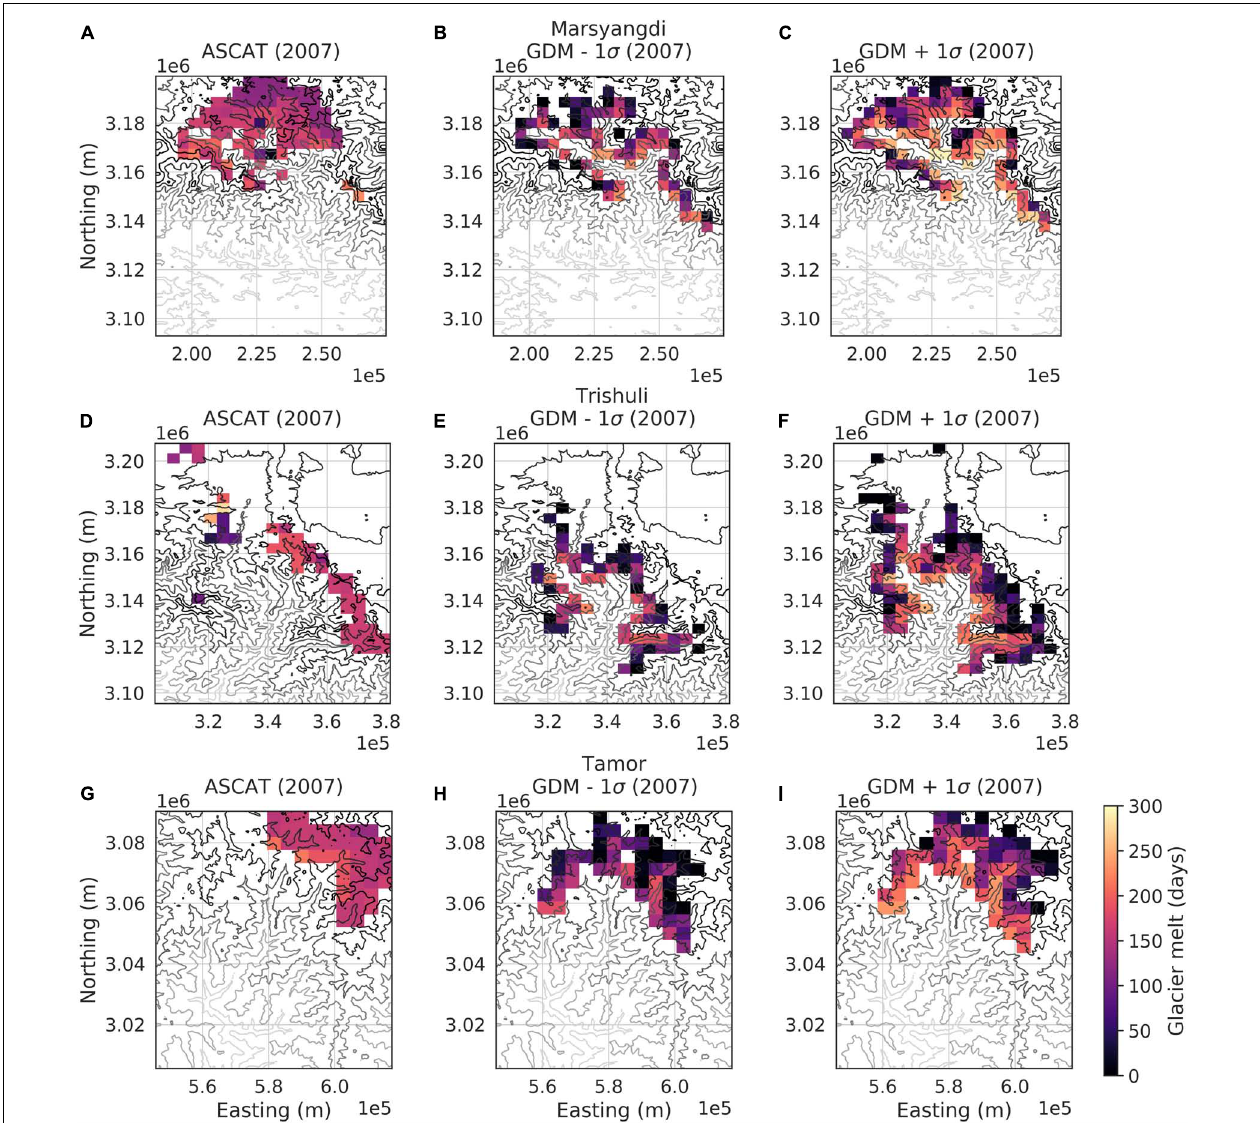
FIGURE 5 | The spatial distribution of glacier melting duration during 2007 for the ASCAT Scatterometer are overlain onto contours of elevation, in m a.s.l., for Marsyangdi, Trishuli, and Tamor River basins along with the GDM. The range of melting illustrated for each basin is resultant from a variation of standard deviation ( σ ) below and above the air temperature and precipitation. The (A) ASCAT observations of melting days for Marsyangdi are shown along with (B) − 1 σ and (C) +1 σ . For the Trishuli River basin, we illustrate (D) ASCAT, (E) − 1 σ , and (F) +1 σ . For the Tamor River basin, we illustrate (G) ASCAT, (H) − 1 σ , and (I) +1 σ